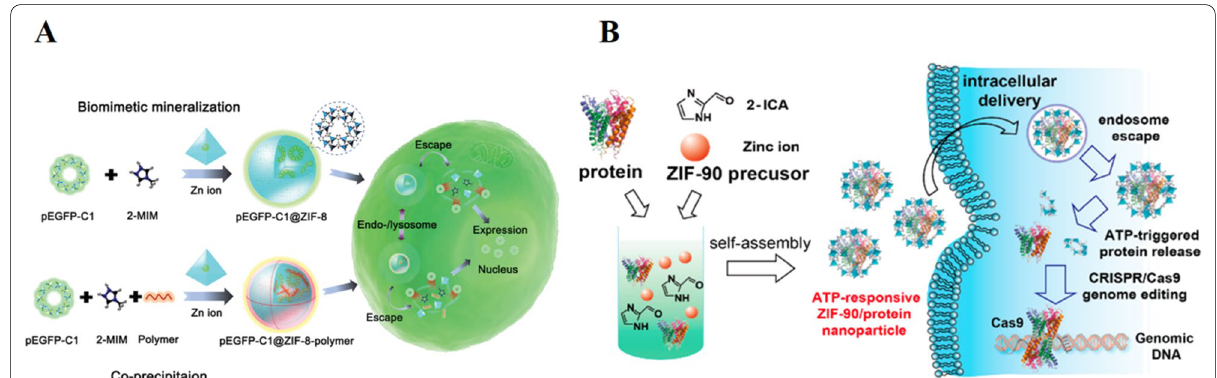
Fig. 1 A Schematic representation for synthesis of pEGFP-C1@ZIF-8 nanostructures and pEGFP-C1@ZIF-8-polymer nanostructures via biomimetic mineralization and coprecipitation method, respectively, and their cellular delivery and expression process [26]. Copyright 2019 American Chemical Society. B Schematic illustration of the self-assembly of ZIF-90/protein nanoparticle and ATP-triggered protein release from ZIF-90 nanoparticle inside cells [29]. Copyright 2019 American Chemical